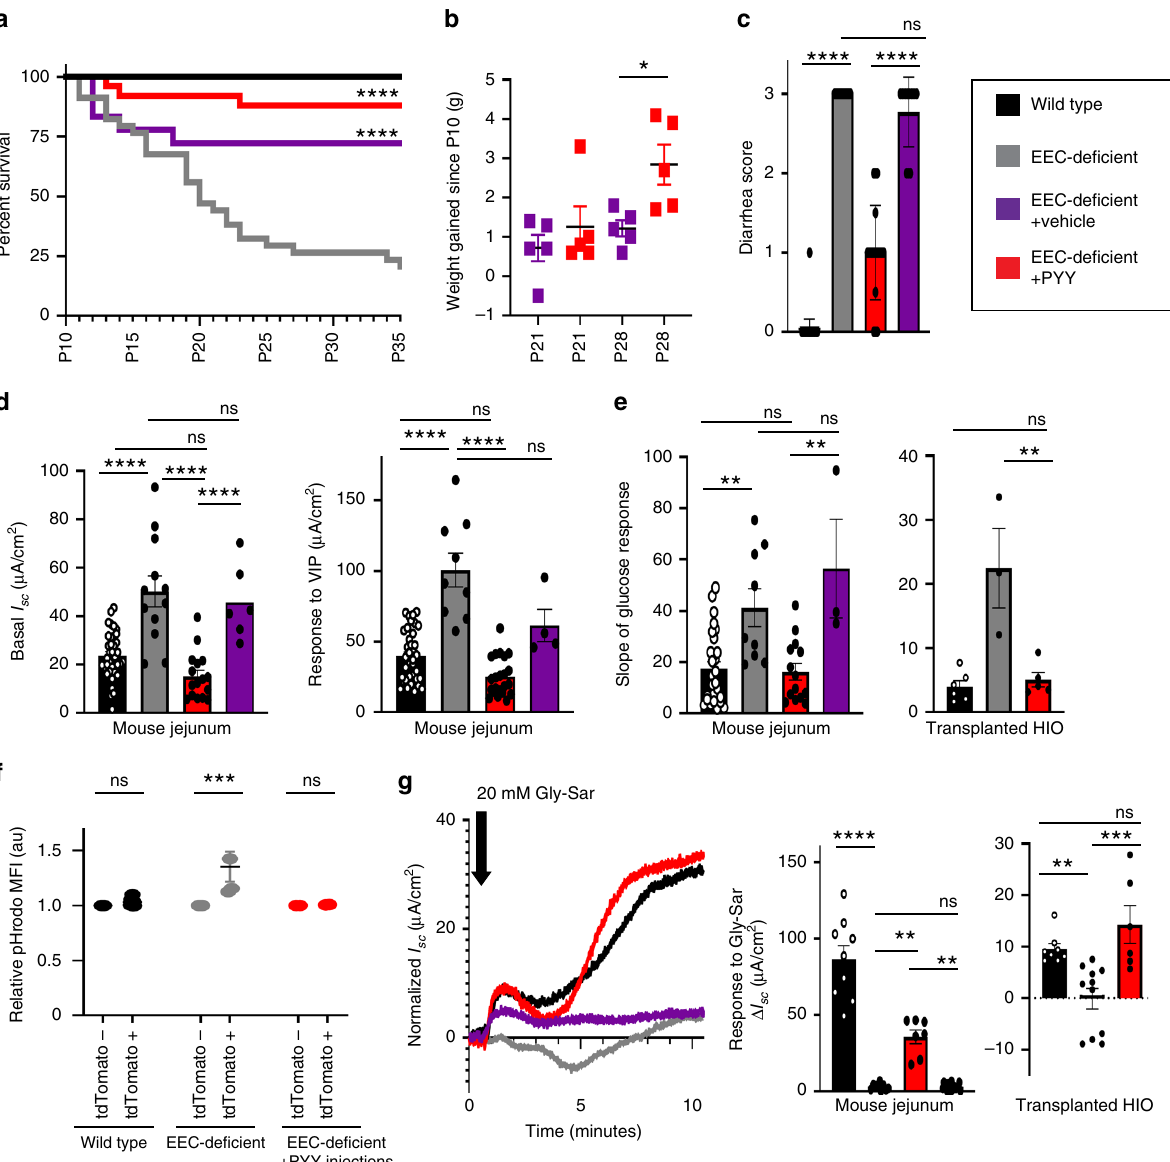
Fig. 4 Exogenous PYY rescues EEC-de fi cient mice from malabsorptive diarrhea and restores normal glucose and dipeptide transport. a Survival